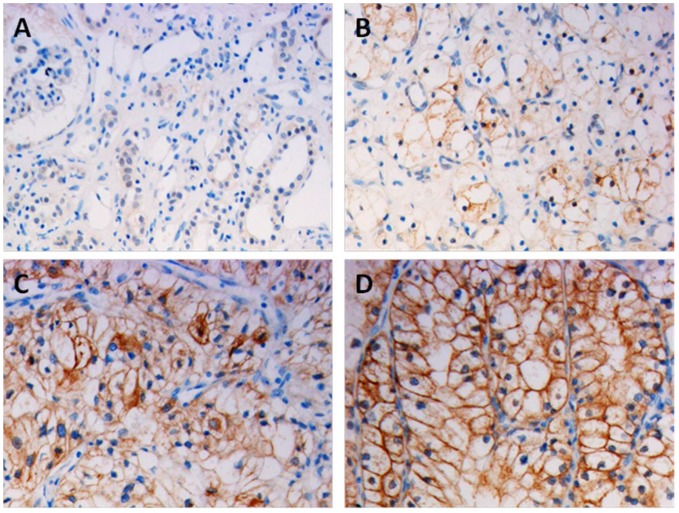
Immunohistochemical analysis of the expression of PNCK protein.PNCK is mainly localized within the nuclei and cytoplasmic. Immunostaining of the adjacent normal tissue samples(A) and the ccRCC tumor tissue samples(B) showed a sharp contrast between the negatively stained infiltrative tumorous area. (B): Negative or weak PNCK staining in cancerous tissue (400×). (C): Moderate PNCK staining in cancerous tissue(400×). (D): Strong PNCK staining in most of tumor cells (400×).